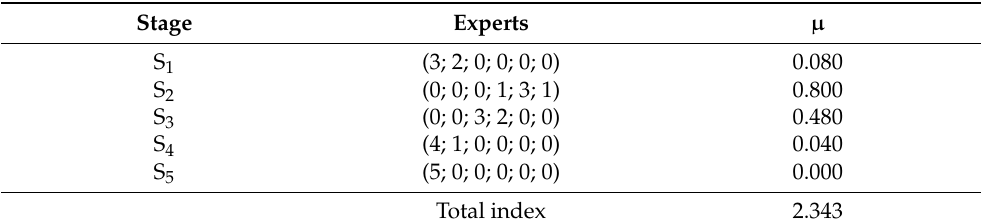
Table 7. Confidence level in the healthcare